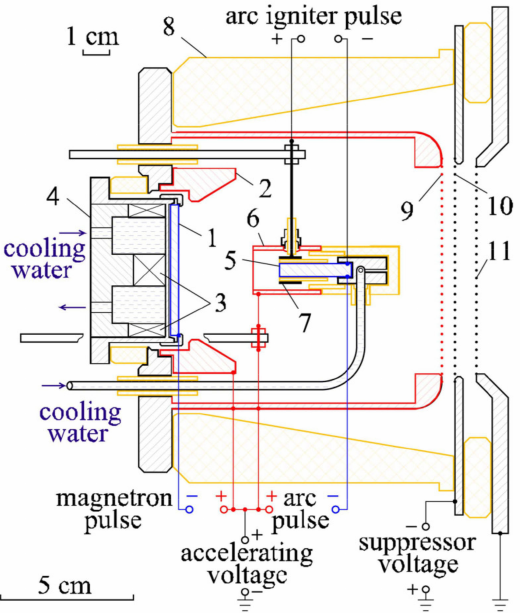
Figure 1. Schematic view of vacuum magnetron discharge ion source. 1—Magnetron target, 2— Magnetron anode, 3—Permanent magnets, 4—Magnetic circuit, 5—Vacuum arc cathode, 6—Vacuum arc anode, 7—Vacuum arc igniter electrode, 8—High voltage insulator, 9—Expander with emission grid, 10—Suppressor electrode, 11—Grounded